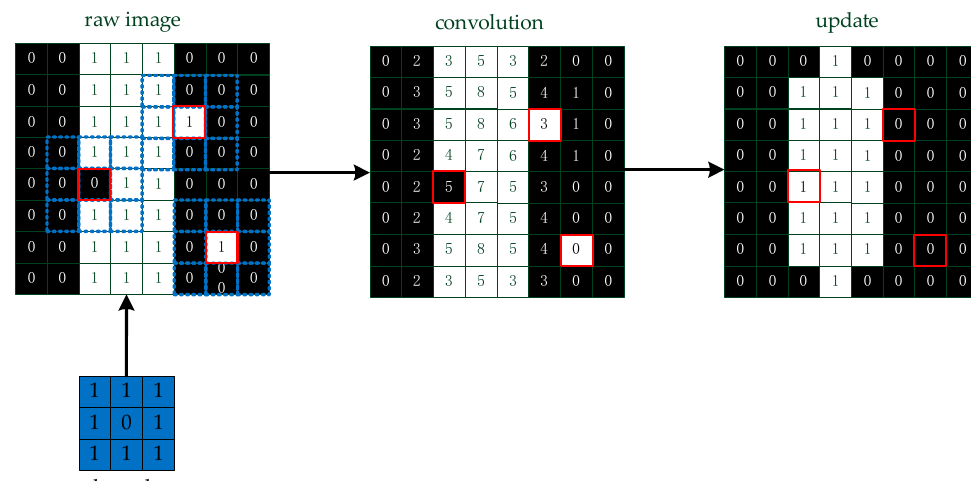
Figure 11. A simple method to remove the burr. We convolve the image and update the pixels of the image based on the convolution